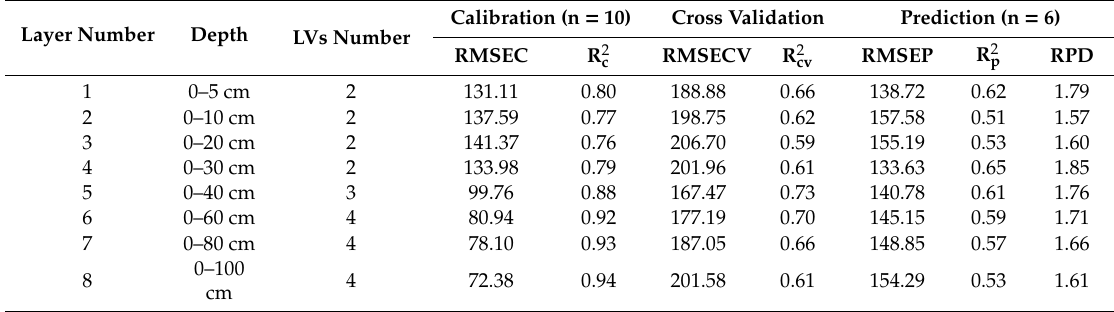
Table 4. Calibration and predication of the profile age using multi-depth spectroscopy. Layer